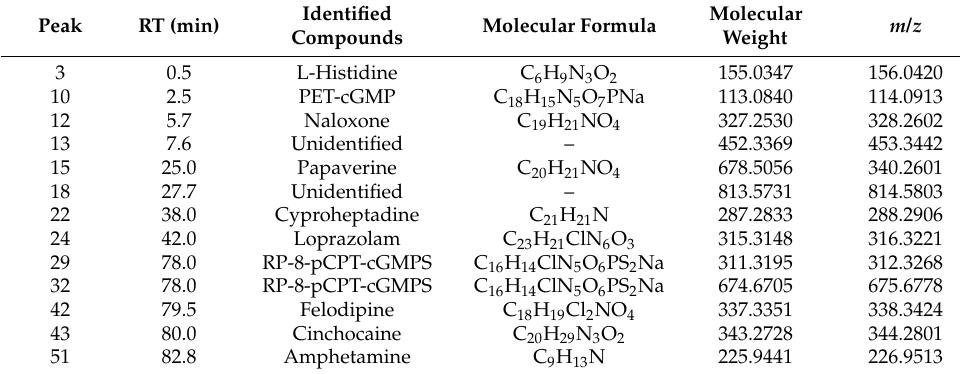
Figure 5. LC-MS/MS chromatogram of G. levis . Table 9. The compounds identified in G. levis .